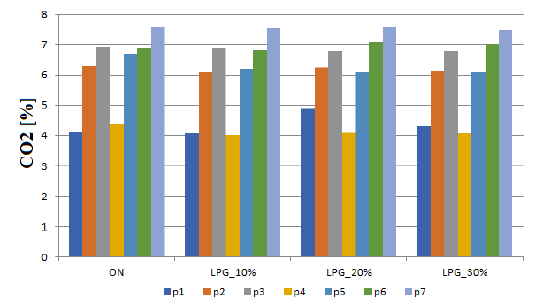
Fig. 13. The comparison of CO 2 emissions